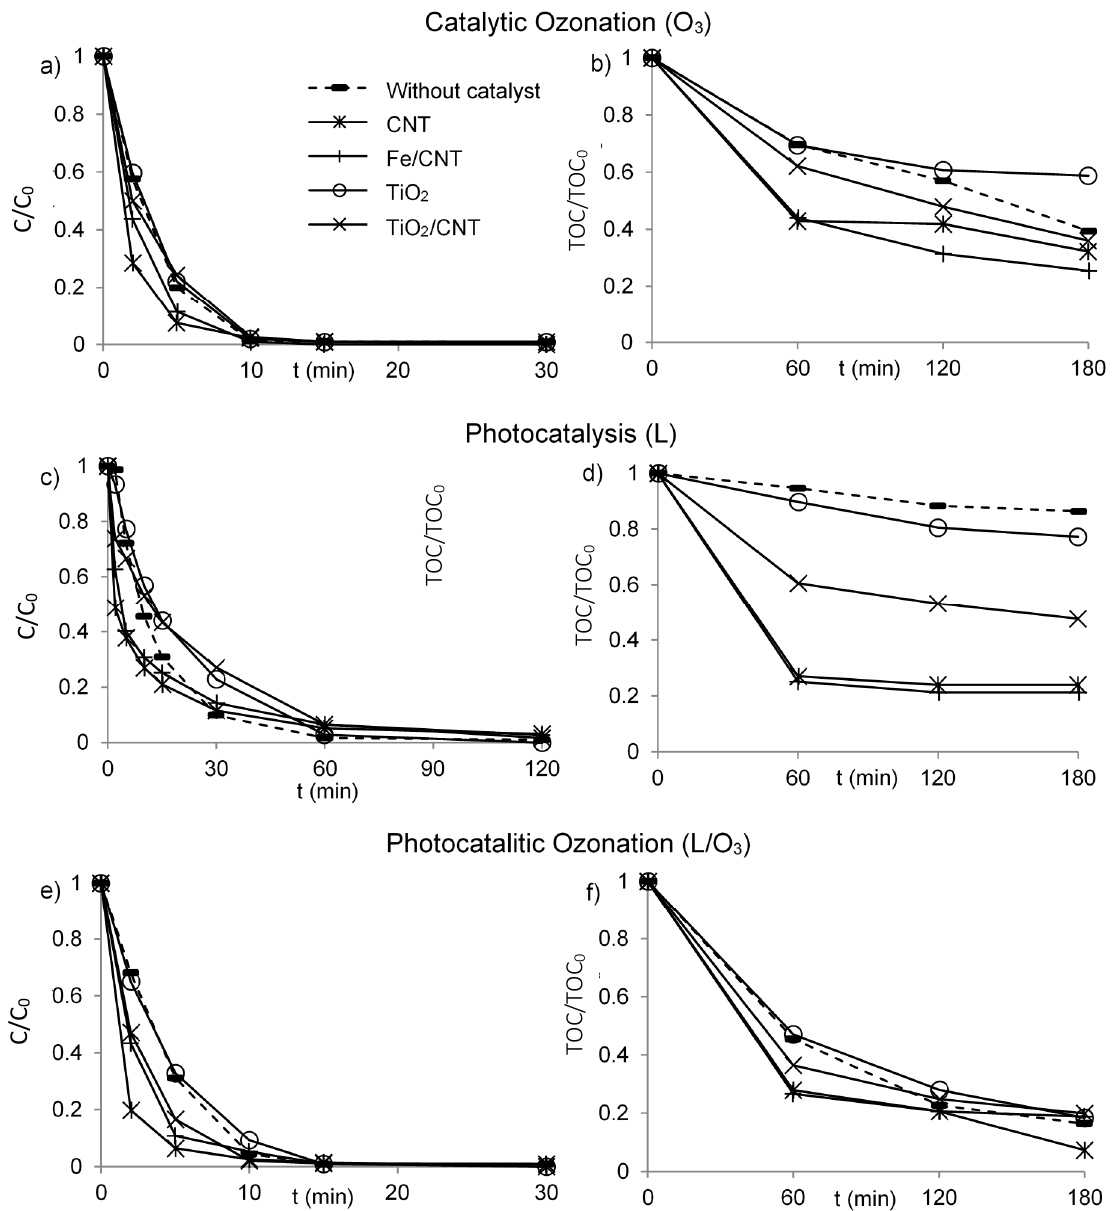
Figure 2. Dimensionless SMX ( a , c , e ) and total organic carbon (TOC) ( b , d , f ) concentration during catalytic ozonation (O 3 ), photocatalysis (L), and photocatalytic ozonation (L/O 3 ) in the presence of CNT, Fe/CNT, TiO 2 , and TiO 2 /CNT.